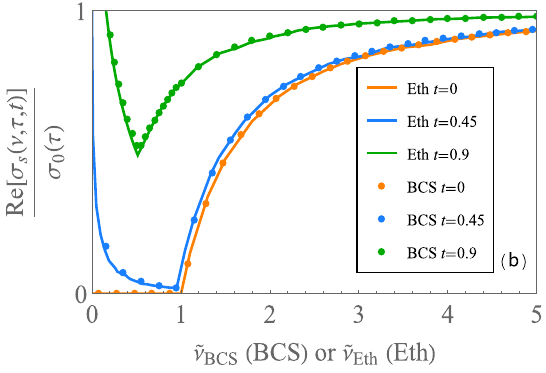
Fig. 3 Electrical conductivities for the Eliashberg and BCS theories. a The Eth ( λ = 0.3)and BCS conductivityratiosversus t ≡ T / T c in the dirty limit.The orange curve isfor Eth with ν / ω E = 10 − 4 . Theblue curve isBCStheory, where we also use ν / ω E = 10 − 4 , which implies ν = Δ BCS 3 : 81 ´ 10 (cid:1) 3 . Here we use Eq. (2.3) for the BCS gap edge Δ BCS the blue data points, for the gap we use the weak-coupling result given in Eq. ffiffiffi p e of1 = gives anelectrical conductivitythatagreeswith the small- λ Eth result. b The frequency-dependent conductivity in Eth ( λ = 0.3) and BCS theory in the dirty limit. The solid curves are for Eth and the points are for BCS theory. different horizontal axes for the Eth and BCS curves.